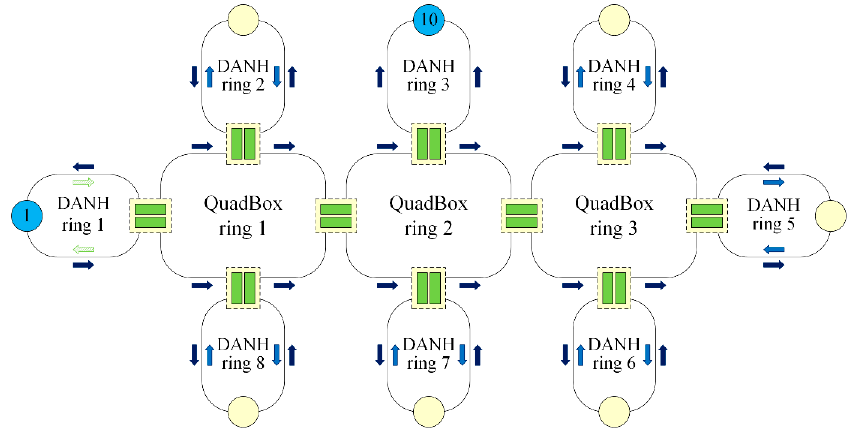
Figure 2. Flooding the first frame to discover nondestination DANH rings in EFA. EFA: effectively filtering approach.